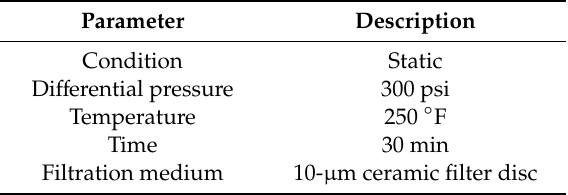
Table 4. Experimental conditions for the high-pressure / high-temperature (HPHT) filtration test.